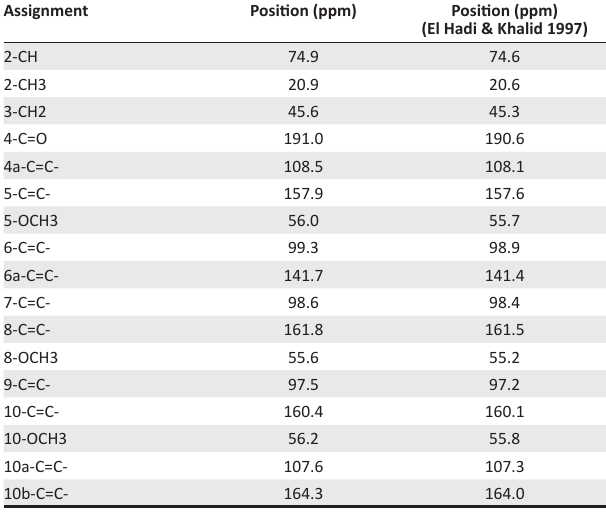
TABLE 2: Comparison between 13 C-NMR spectral data (600MHz, CDCl subfraction (4/7/5) and 5-methyl-dihdroflavasperone.